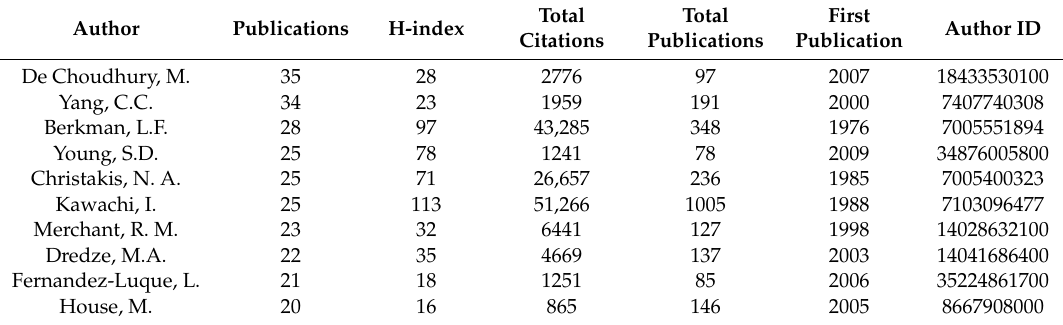
Table 7. Top 10 authors published in the topic, with h-index, citations, and total